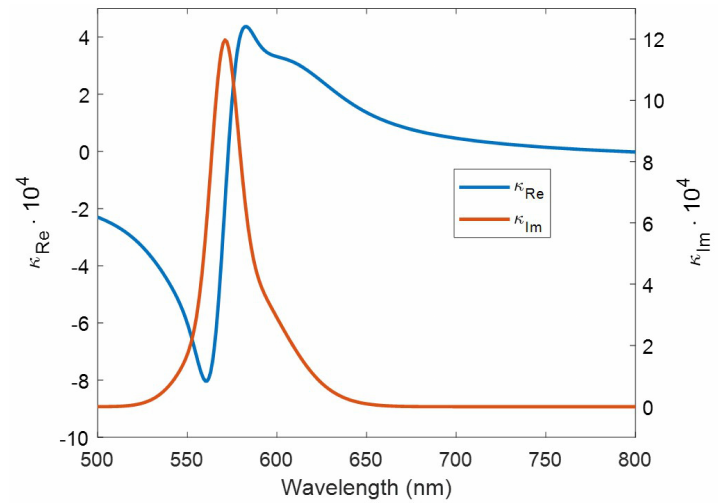
Figure 9. Model function with two Gaussian resonances for the chirality parameter κ of the elytron from C. aurata (sample CA1).